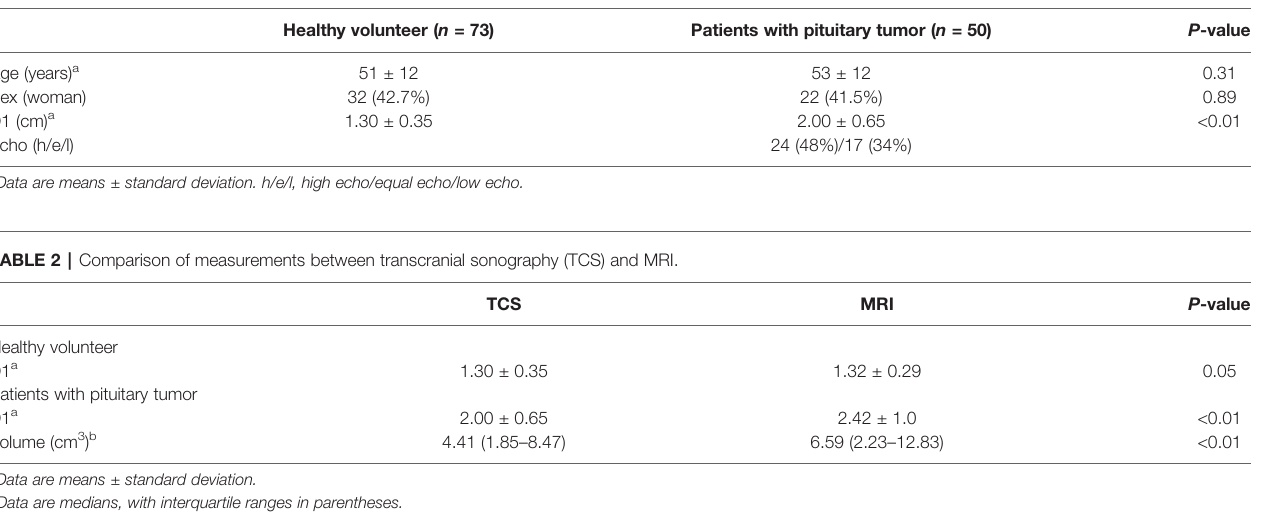
TABLE 1 | Demographics and characteristics of transcranial sonography patients.